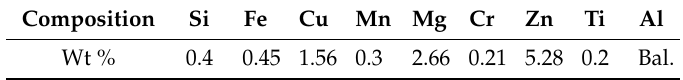
Table 1. The chemical composition of the studied aluminum alloy 7075.